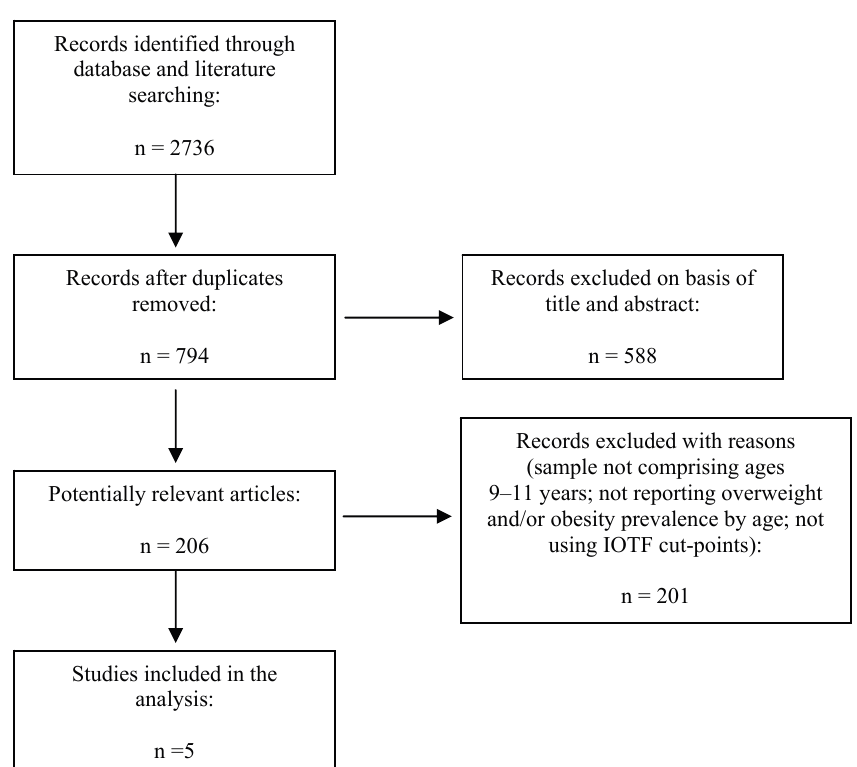
Figure 1. Flow diagram of study selection for meta-analysis.